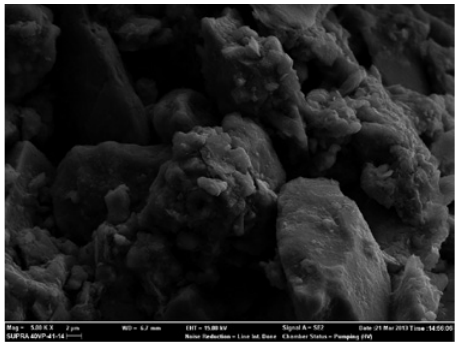
Figure 8 SEM images of silt samples (magnification ×